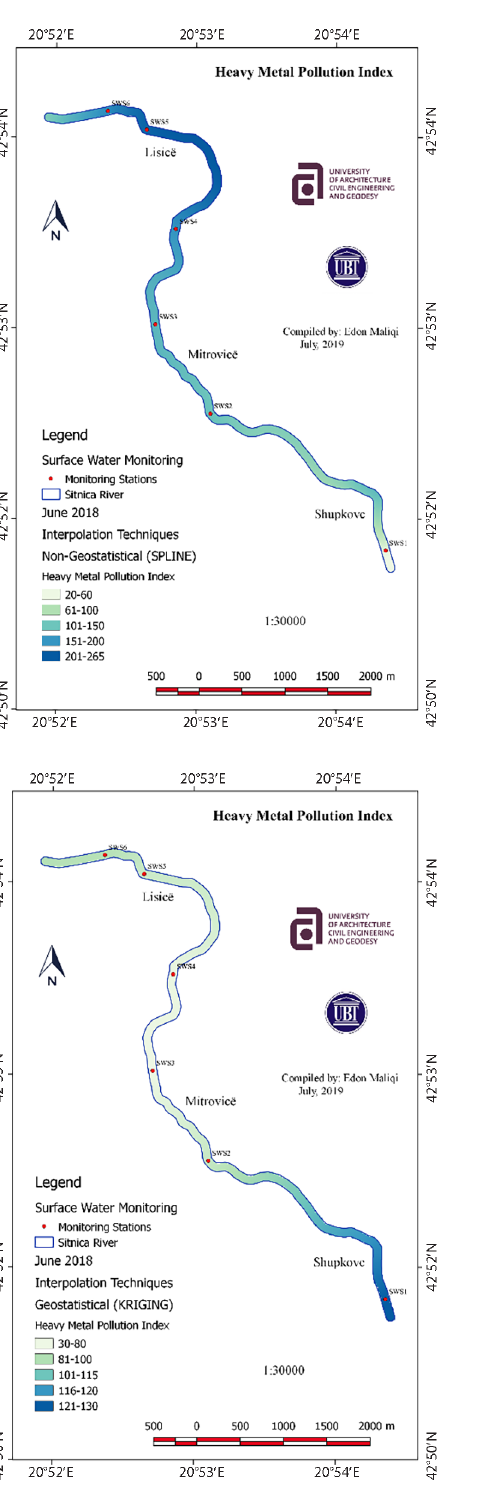
Figure 5. Thematic maps of June (2018) by using Spline and Kriging (HPI &